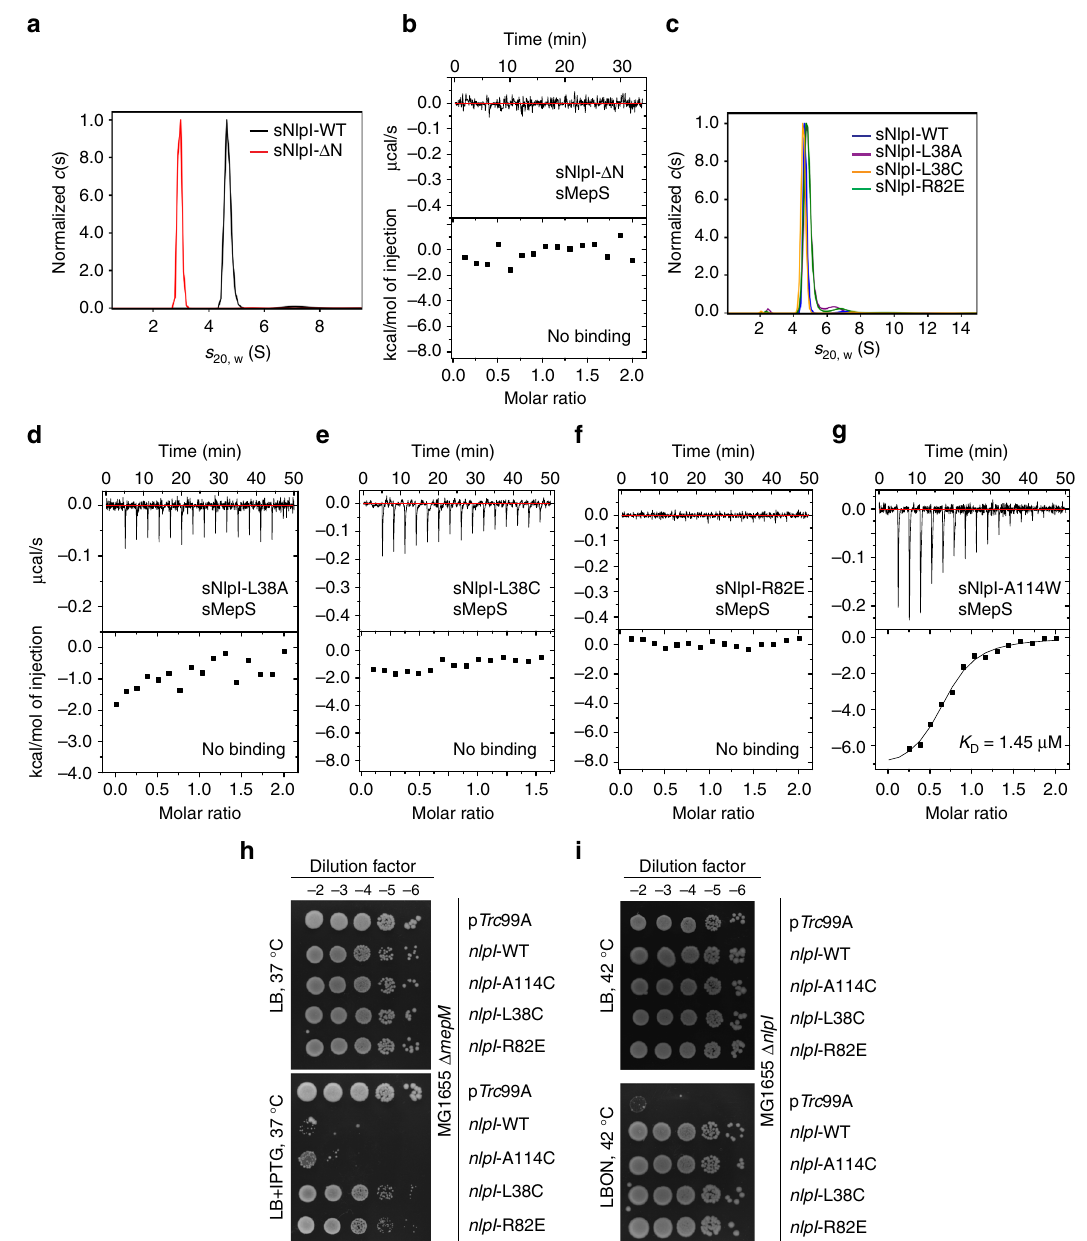
Fig. 7 Mutational analysis of NlpI-MepS interaction. a Sedimentation velocity pro fi les of dimeric wild-type sNlpI and monomeric sNlpI- Δ N. b ITC analysis of the interaction of sNlpI- Δ N with sMepS showing no binding. c Sedimentation velocity pro fi les of sNlpI mutants showing dimer formation. d – g ITC analysis of the interaction of sMepS with sNlpI-L38A d , sNlpI-L38C e , sNlpI-R82E f , and sNlpI-A114W g . h and i Effect of nlpI -L38C overexpression in cells of MG1655 Δ mepM h or MG1655 Δ nlpI i containing p Trc 99A or pCHT93 carrying the WT or mutant nlpI derivatives. Viability assays were done similarly as in Fig. 5c, with or without 0.05 mM